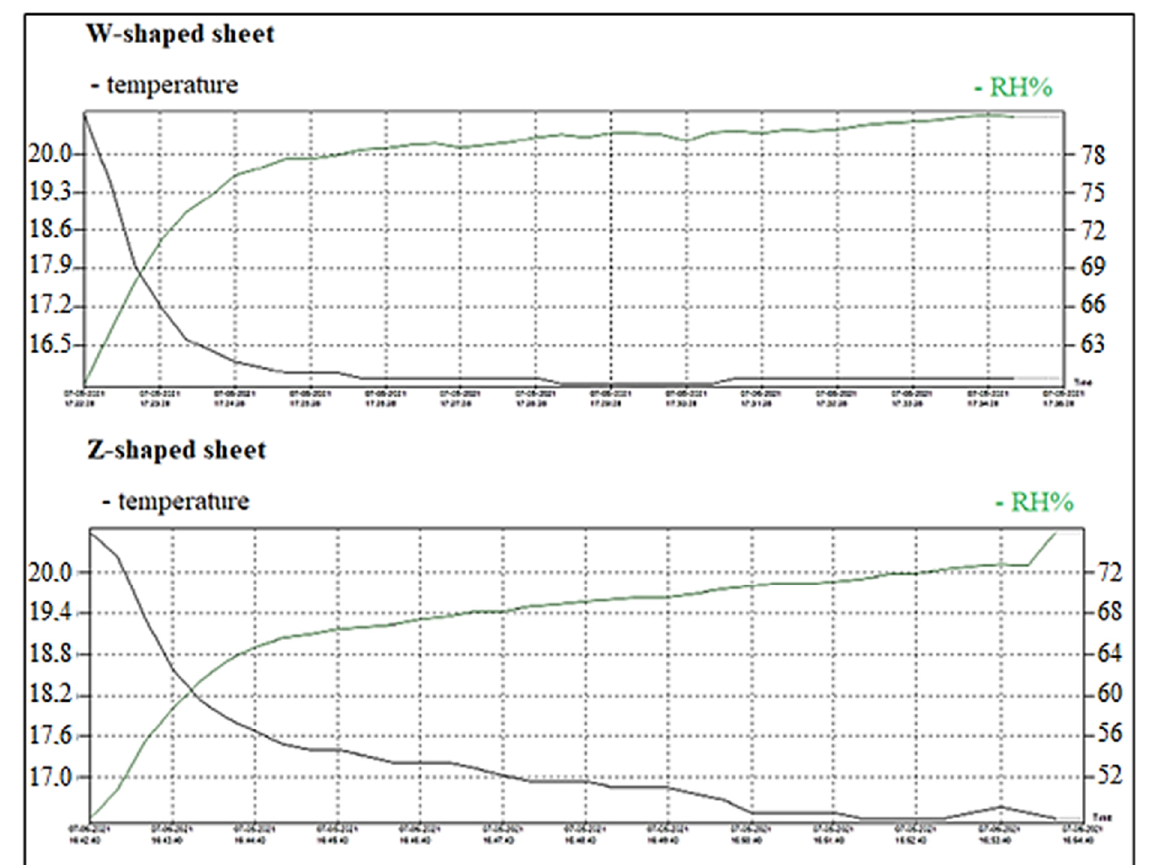
Figure 6. The temperature and RH measurement diagram (continuous measurement, pad testing sequence).